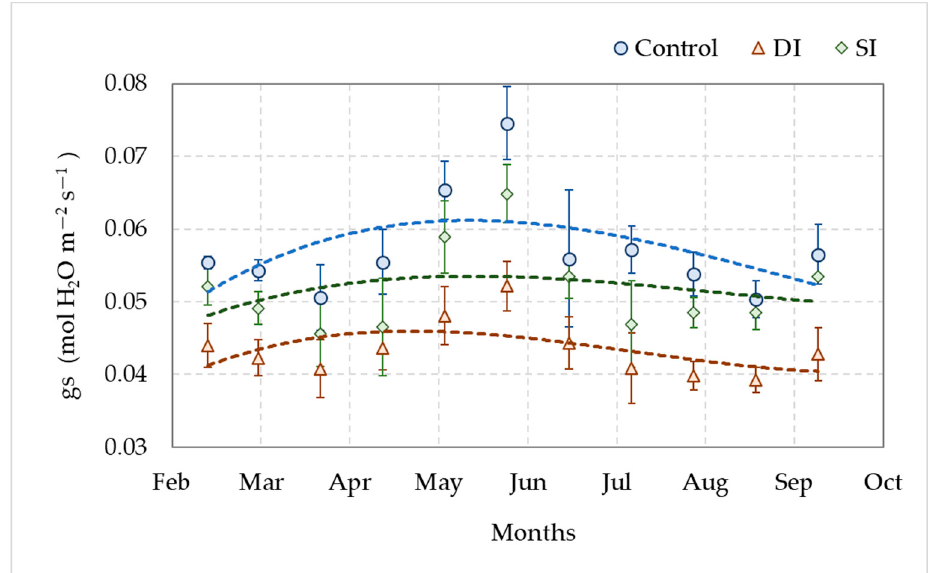
Figure 9. Effect of drip irrigation (DI), subsurface irrigation (SI), and bubbler irrigation (control) systems on stomatal conductance (gs) of date palm (Khalas cv.). Each data point for SI and DI systems represents an average of 50, 75, and 100% ETc levels, whereas it is at 100% ETc level for control during 2020–2021.